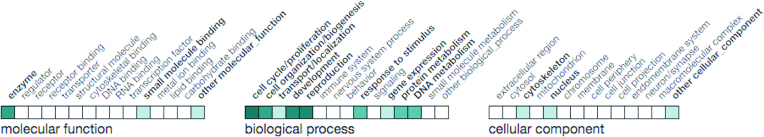
GO Summary Ribbon. GO summary ribbon for D. melanogaster gene Cdk1, as embedded in a FlyBase Gene Report.